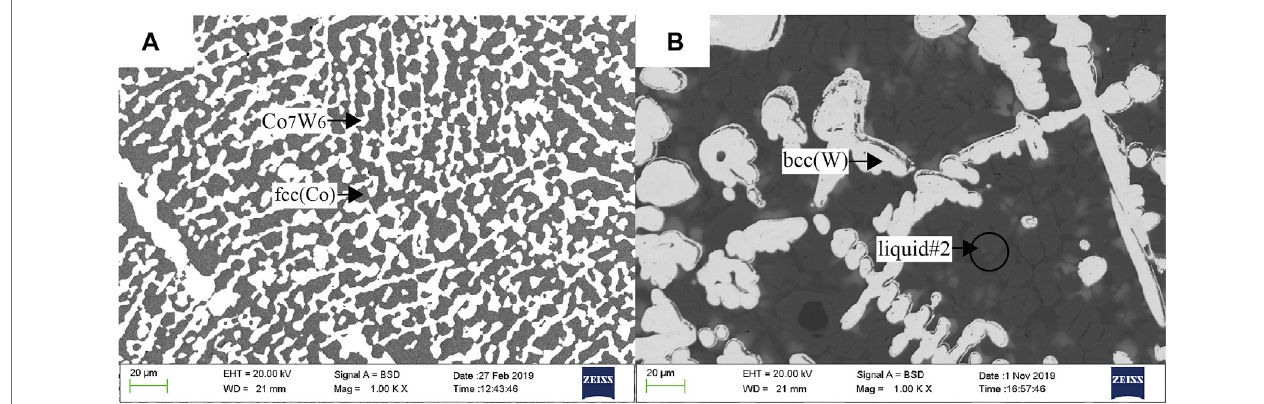
FIGURE 10 | BSE micrographs of alloys (A) for b9 (B) for b10.